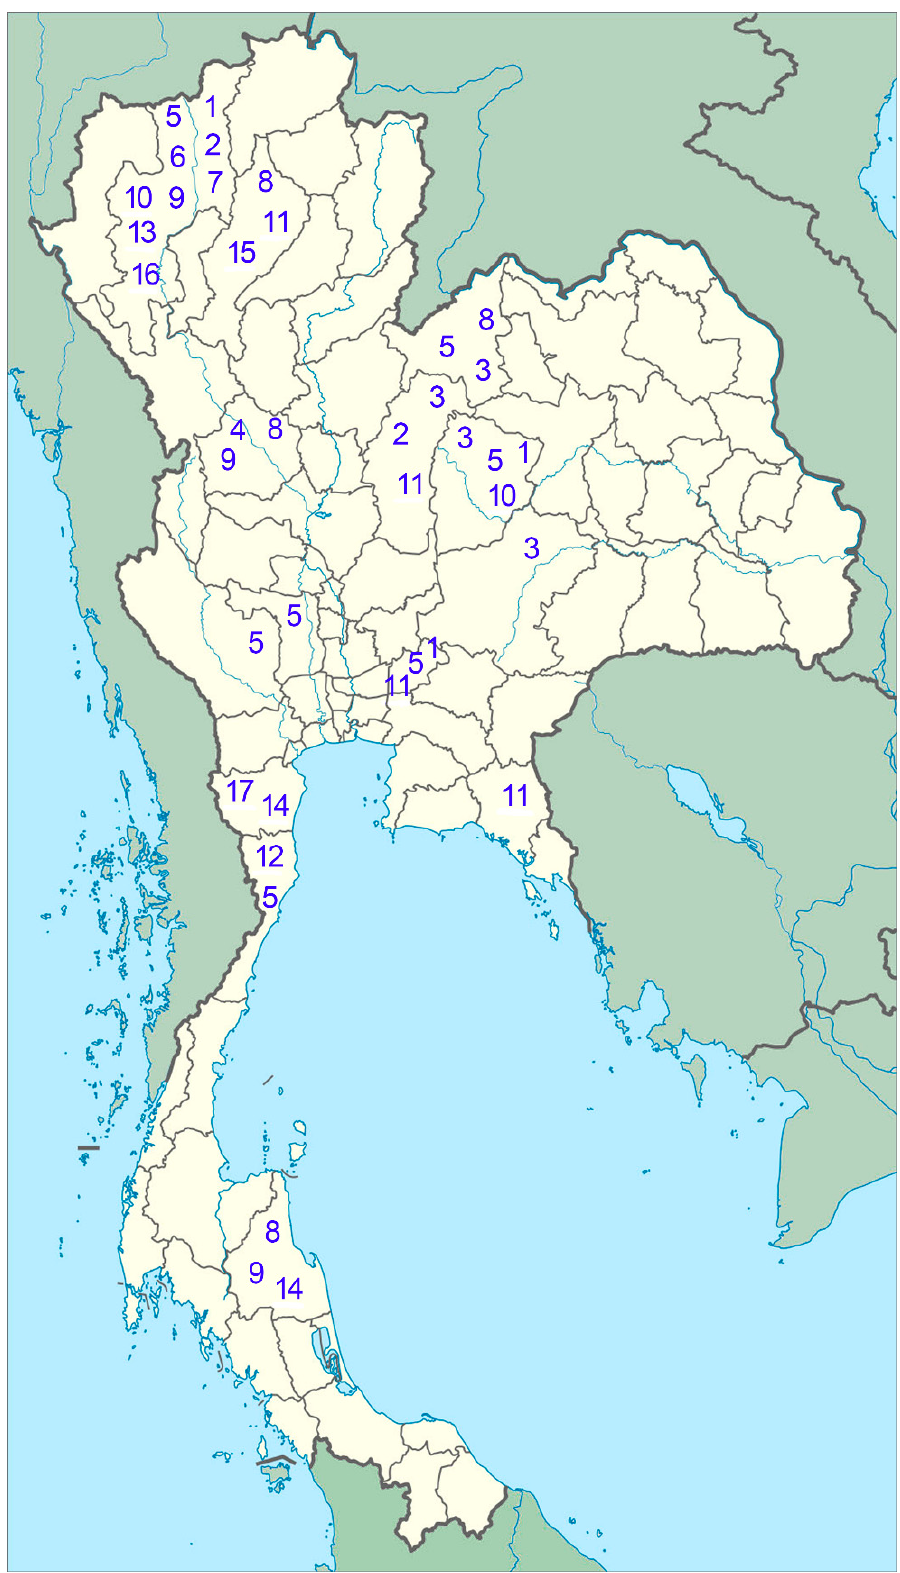
Figure 27. Geographical distributions of Xestocephalus species in Thailand. As shown in the figure: 1 . X. asper ; 2 . X. guttulatus ; 3 . X. ishidae ; 4 . X. gracilus sp. nov.; 5 . X. nonattribus sp. nov.; 6 . X. binarius sp. nov.; 7 . X. densprint sp. nov.; 8 . X. toroensis ; 9 . X. chrysanthemum sp. nov.; 10 . X. tenusis sp. nov.; 11 . X. exproiecturus sp. nov.; 12 . X. abyssinicus ; 13 . X. cowboyocreus sp. nov.; 14 . X. recipinams sp. nov.; 15 . X. limpidissimus sp. nov.; 16 . X. dimiprocessus sp. nov.; 17 . X. malleus sp. nov.